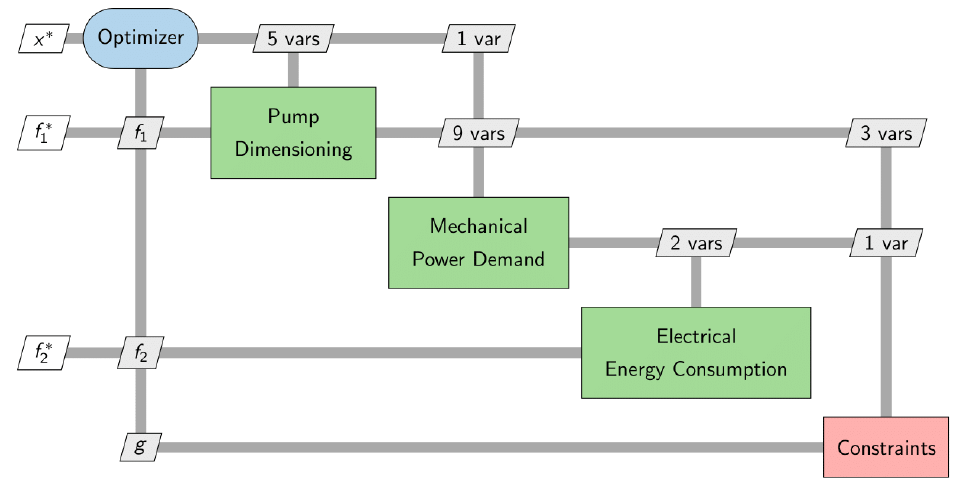
Figure 15. XDSM of the optimization